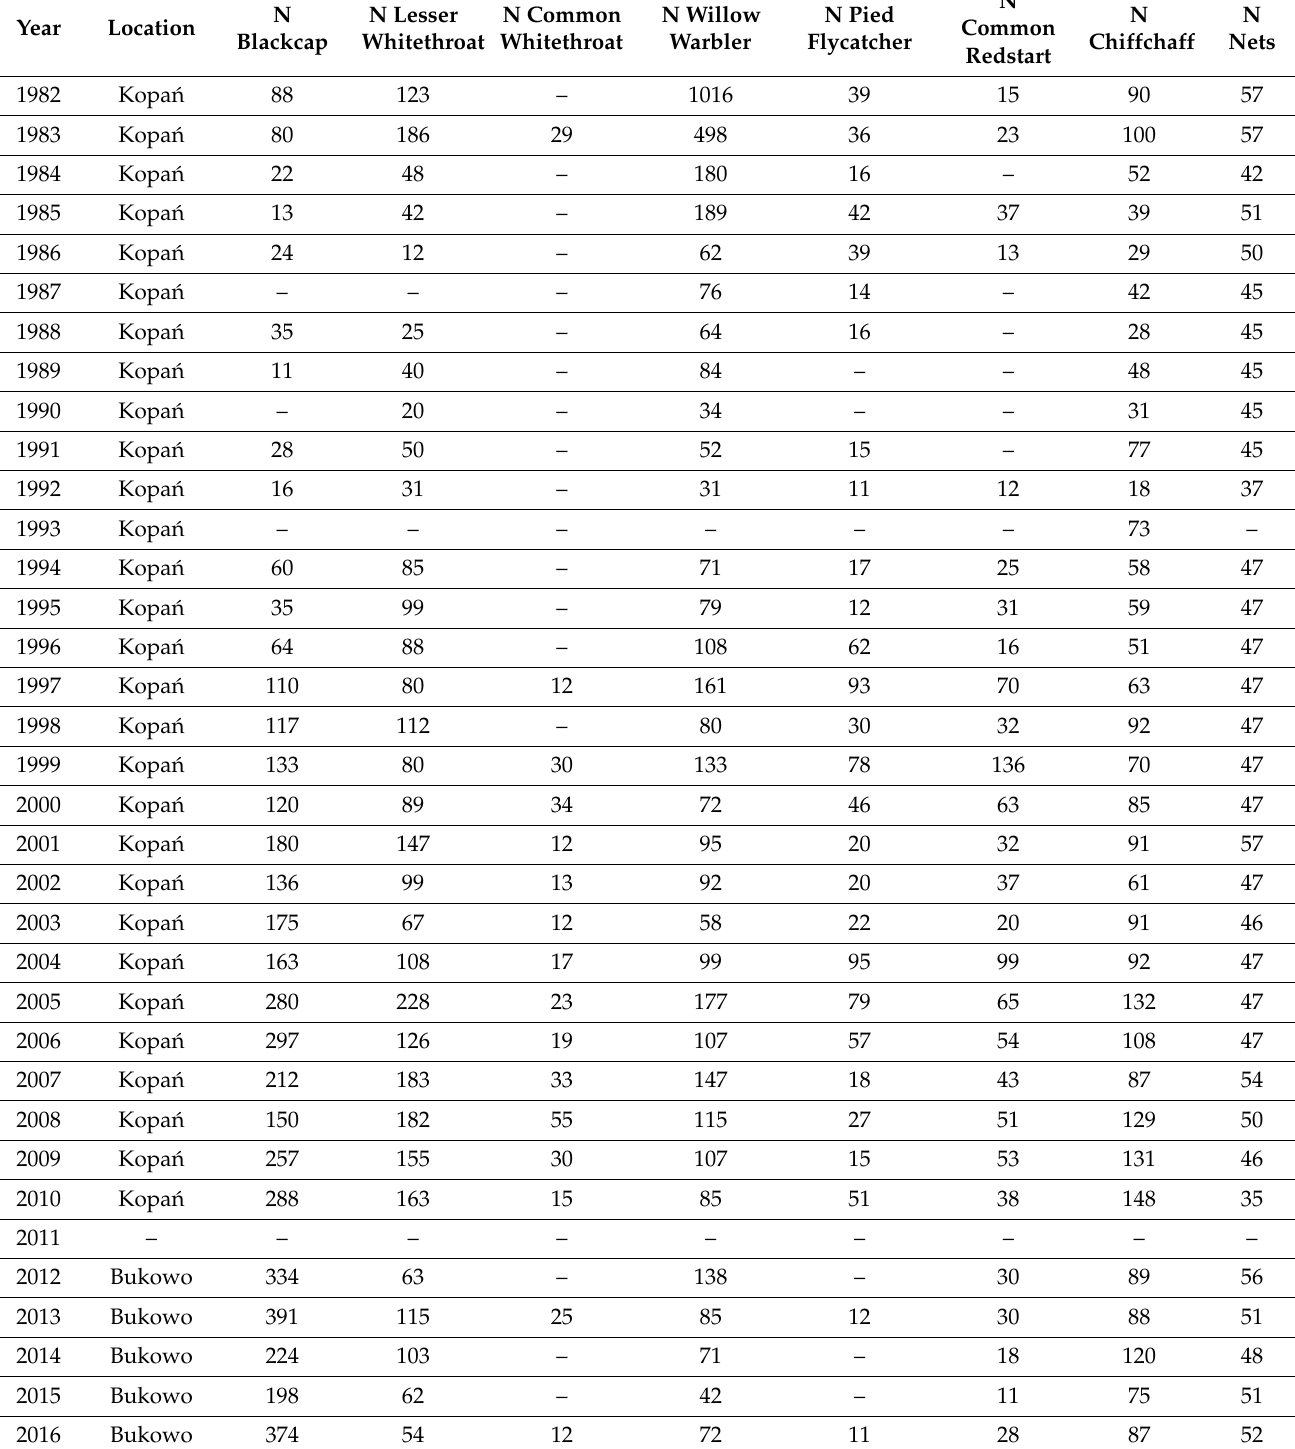
Table A1. The numbers of six migrants ringed each spring in 1981–2021 at both locations of the Bukowo ringing station, the numbers of mist nets used and numbers of birds caught each season of the study. The two locations are 16 km apart: Kopa´n (54 ◦ 27 (cid:48) 11 (cid:48)(cid:48) N, 16 ◦ 24 (cid:48) 08 (cid:48)(cid:48) E) and Bukowo (54 ◦ 20 (cid:48) 13 (cid:48)(cid:48) N, 16 ◦ 14 (cid:48) 36 (cid:48)(cid:48) E). N = numbers of birds of each species caught each spring (1 April–15 May), aged as “full grown”; N nets = number of 8 m passerine mist nets used each season, “–” = seasons excluded from analysis because fewer than 10 birds were caught; N years = numbers of years analysed for each